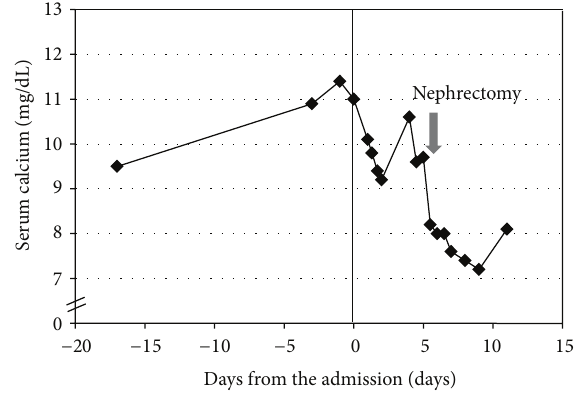
Figure 1: Trends of serum calcium. Note that serum calcium is not corrected for albumin level. Albumin on admission was 3.6 grams/dL, while albumin before the nephrectomy was 2.8